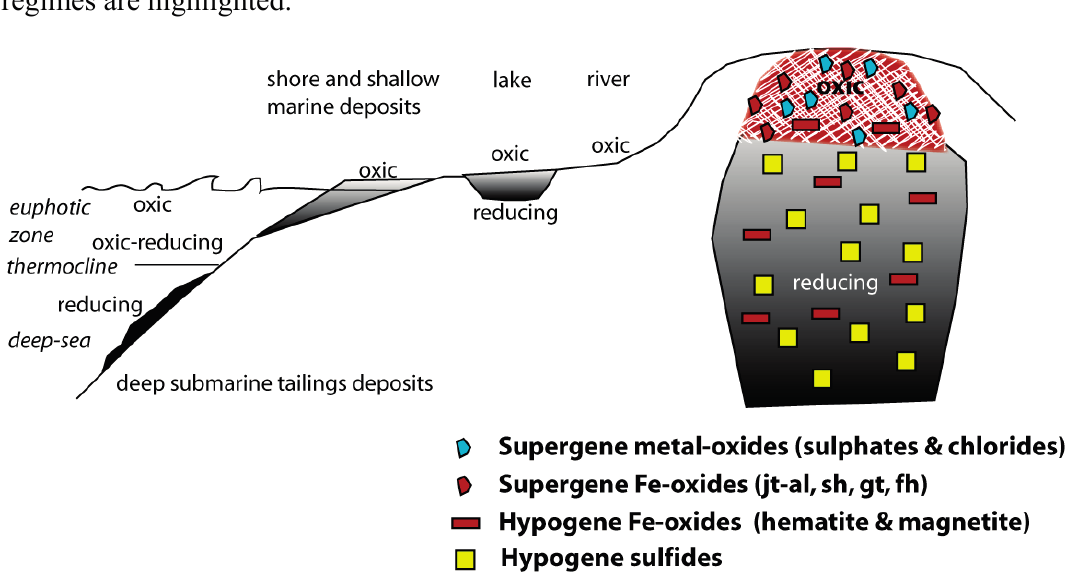
Figure 2. Schematic model of a sulphide ore deposit (porphyry), with the zones, where sulphides, oxides, and sulphates/chlorides may dominate the mineral assemblage. This zoning is a strong simplification and the different mineral groups may coexist. On the left, the different tailings disposal options in water bodies and their dominant geochemical regimes are